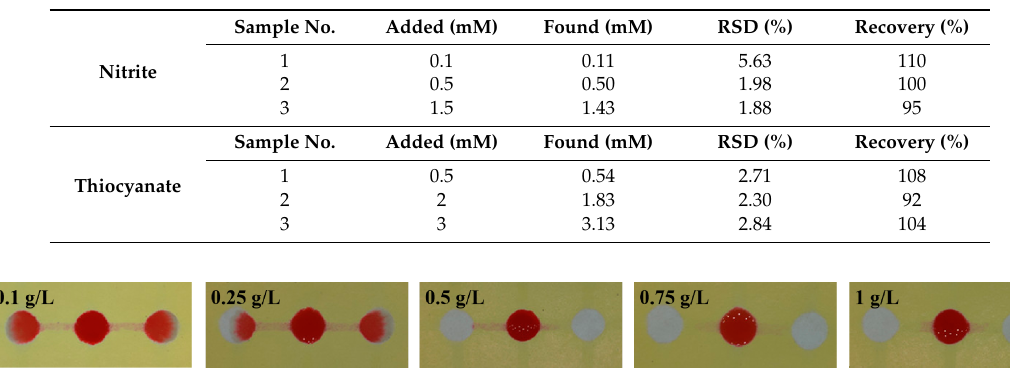
Figure 10. The pictures of the top surface of the 3D sl- μ PADs after adding different concentrations of sodium carboxymethylcellulose (SCMC) solutions in the central well.